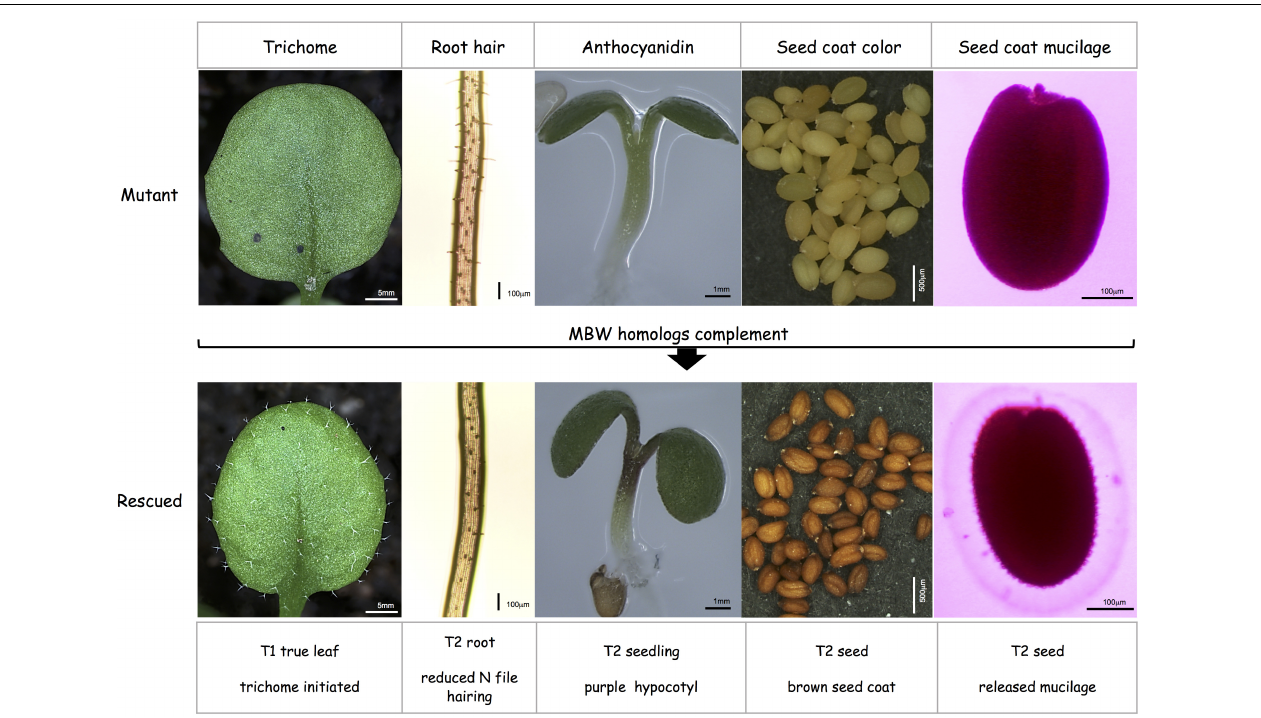
FIGURE 1 | Rescue strategy for the five TTG1-dependent traits in Arabidopsis mutants. (Top row) ttg1 mutant or gl3 egl3 tt8 triple mutant phenotypes display glabrous rosette leaves, extra root hairs in N-files, no anthocyanidin production under stress conditions in the hypocotyl, yellow seeds and no seed coat mucilage release. (Bottom row) rescue by the expression of MBW homologs: recovery of trichomes, suppression of extra root hairs in N-files, purple hypocotyls under stress conditions, brown seeds and the release of seed coat mucilage (light pink Ruthenium Red labeled region around the seed).